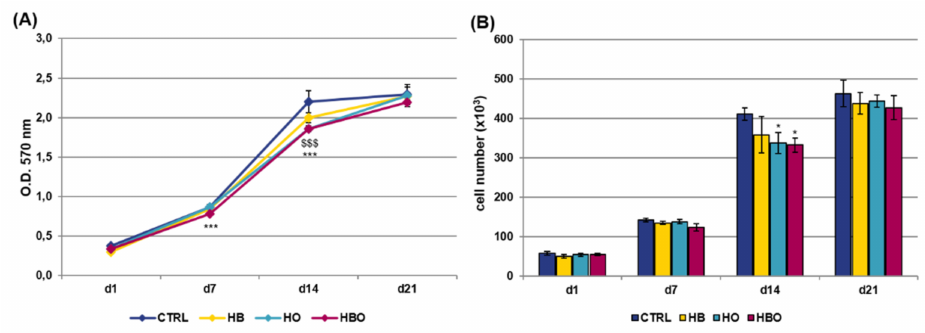
Figure 1. Metabolic activity and proliferation of human Adipose-Derived Stem Cells (hADSCs) after hyperbaric oxygen (HBO) treatment. ( A ) MTT assay and ( B ) quantification of DNA content in hADSCs 1 day (d1), 7 days (d7), 14 days (d14), and 21 days (d21) after osteogenic di ff erentiation in Osteogenic Di ff erentiation Medium (ODM) and hyperbaric oxygen (HBO), hyperbarism (HB), or hyperoxia (HO) treatment. The control condition (CTRL) is represented by cells grown under normoxia and normobarism. Data are shown as mean ± standard deviation (SD). * p < 0.05, *** and $$$ p < 0.001 indicate statistically significant di ff erence between the HBO- or HO-treated cells and the control group,